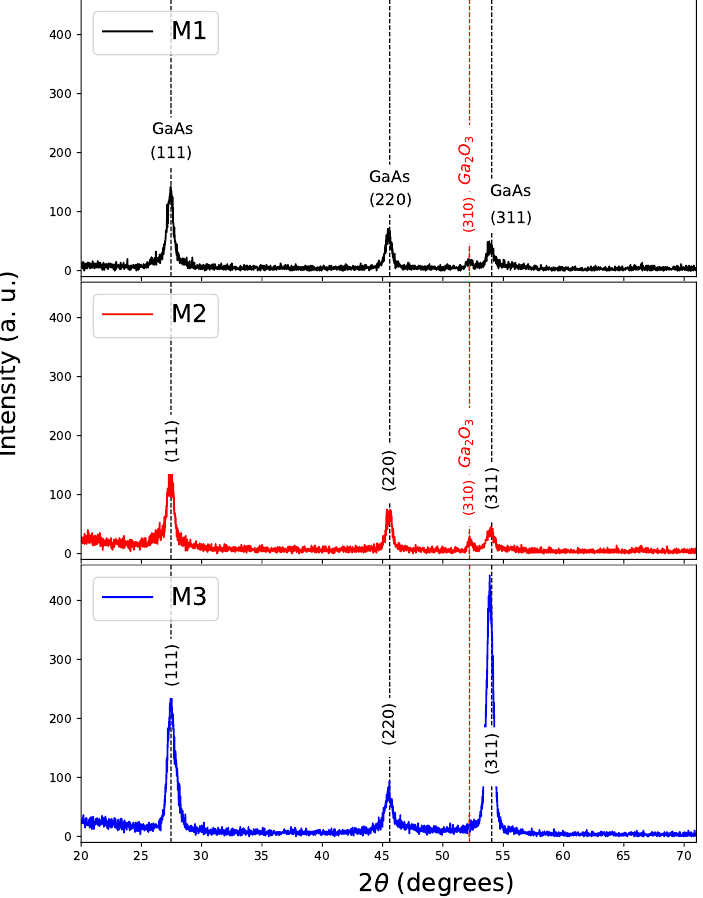
Figure 2. XRD of samples with GaAs Films. M1 (800 ◦ C), M2 (900 ◦ C), and M3 (1000 ◦ C) in the